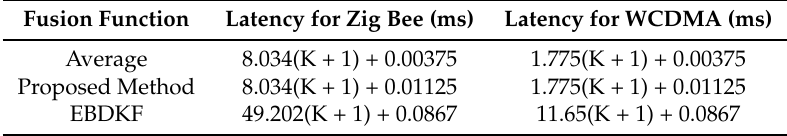
Table 7. Network latency of different information fusion functions for non-hierarchical sensor